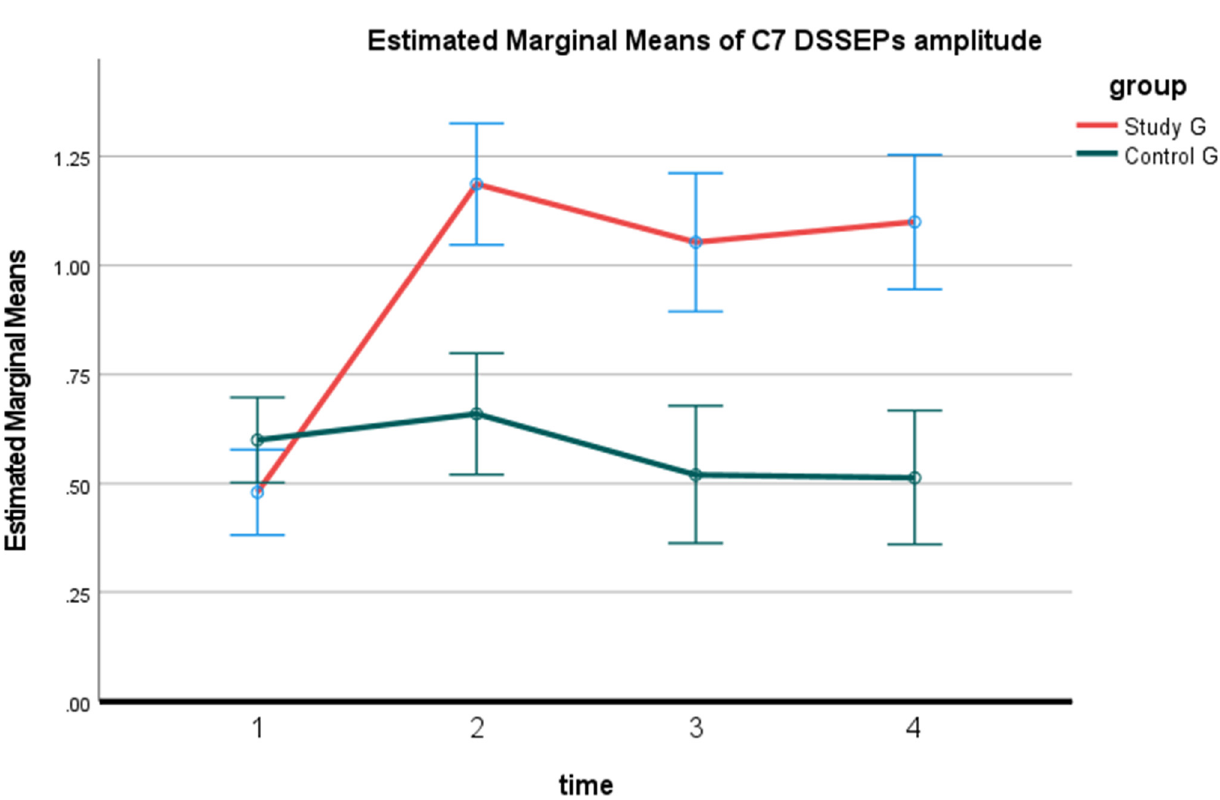
Figure 7. Mean and ± SD of the DSSEPS for study and control groups at four time periods: baseline or pretreatment, after completion of the 10-week program, the 3-month follow-up, and the 2-year follow-up.